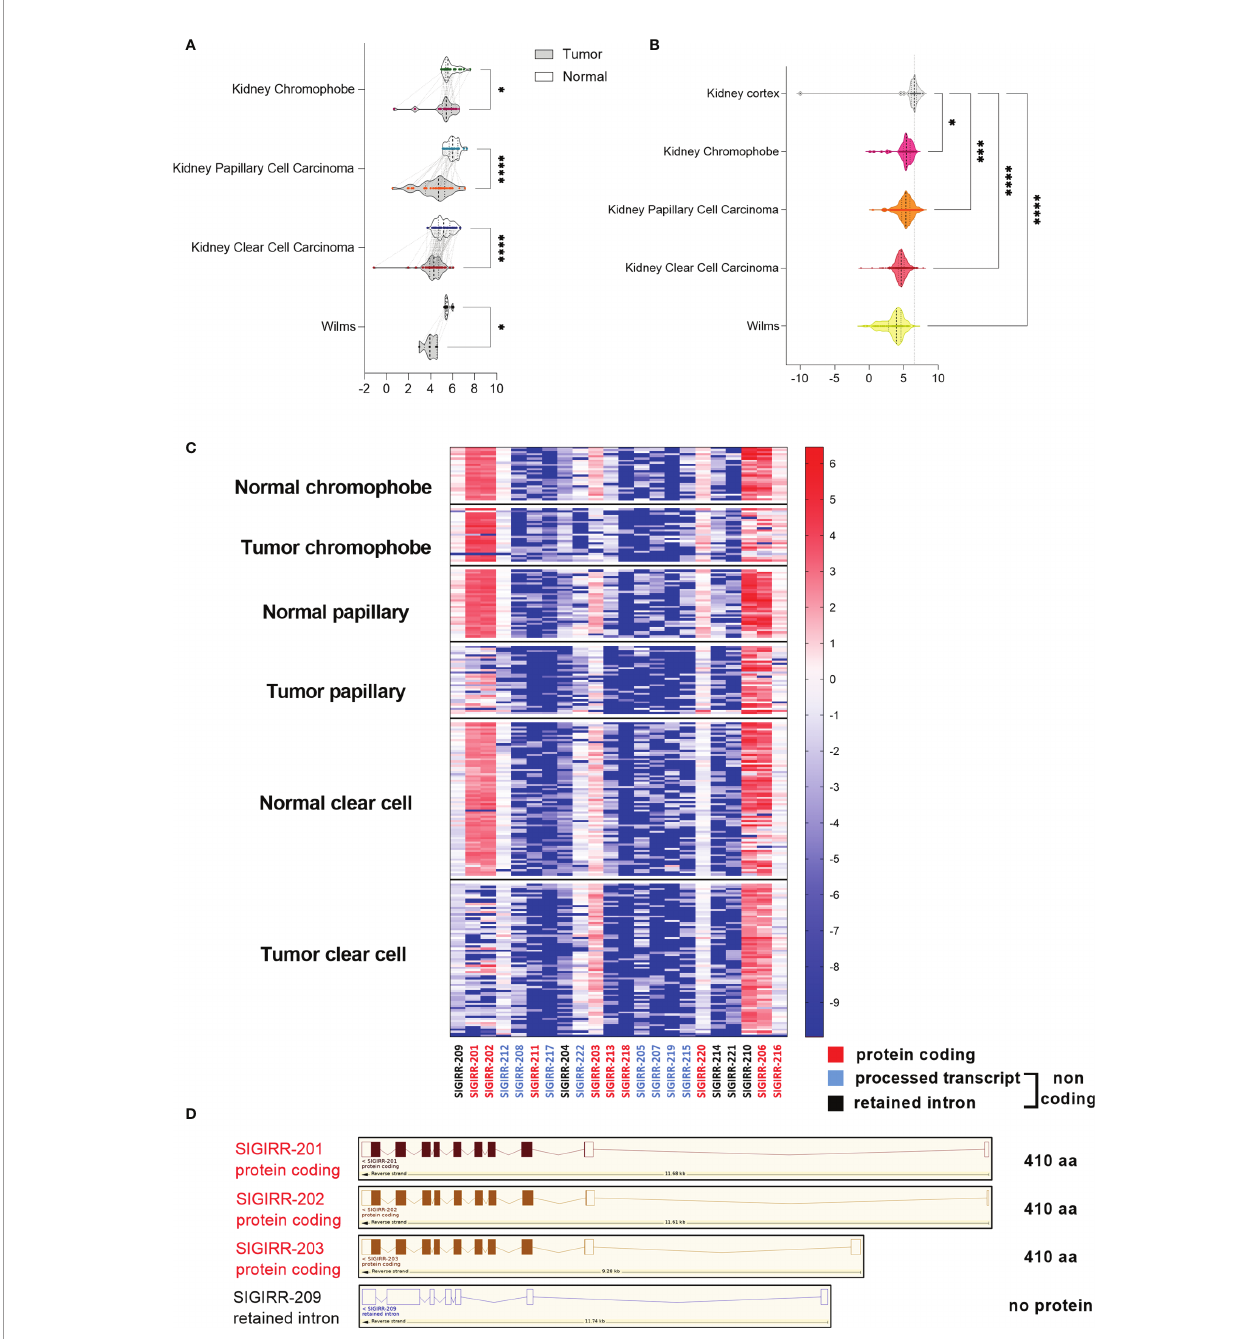
FIGURE 2 | SIGIRR is downregulated in kidney cancer. (A) Bioinformatic analysis of transcriptomic pro fi les in different kidney tumor histotypes compared with their adjacent non-tumor tissue was performed with Xena Browser (data from TCGA database). SIGIRR expression levels are reported in chromophobe (n = 25), papillary (n = 32), clear cell carcinoma (n = 72), and Wilms tumor (n = 5) versus their non-tumor counterpart., *p<0,05; ****p<0,0001 (B) RNA-seq data relative to the SIGIRR expression level in chromophobe (n = 66), papillary (n = 32), clear cell carcinoma (n = 531), and Wilms tumor (n = 126) versus normal kidney cortex (n = 28). RSEM- normalized expression levels are represented with the violin plot, *p<0,05; ***p<0,001; ****p<0,0001. (C) Heatmap representation of the difference between SIGIRR isoforms ’ expression in chromophobe, papillary, and clear cell carcinoma versus their non tumor counterpart. Red labeling refers to protein coding isoforms, blue to processed transcript, and black to retained intron isoforms. (D) Schematic representation of SIGIRR human gene and isoforms (ENSG00000185187; www.ensembl. org). Only the most differentially expressed isoforms are